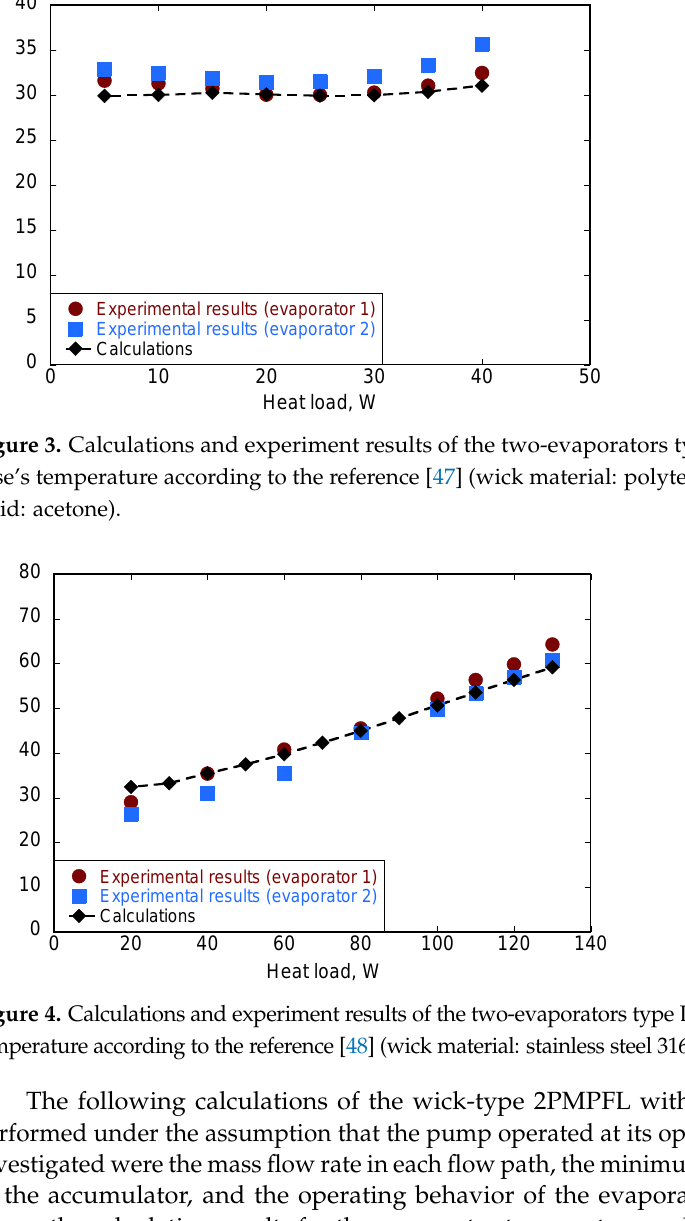
Figure 5. Calculation results of the evaporator temperature and accumulator’s lowest temperature under even heat loads conditions.